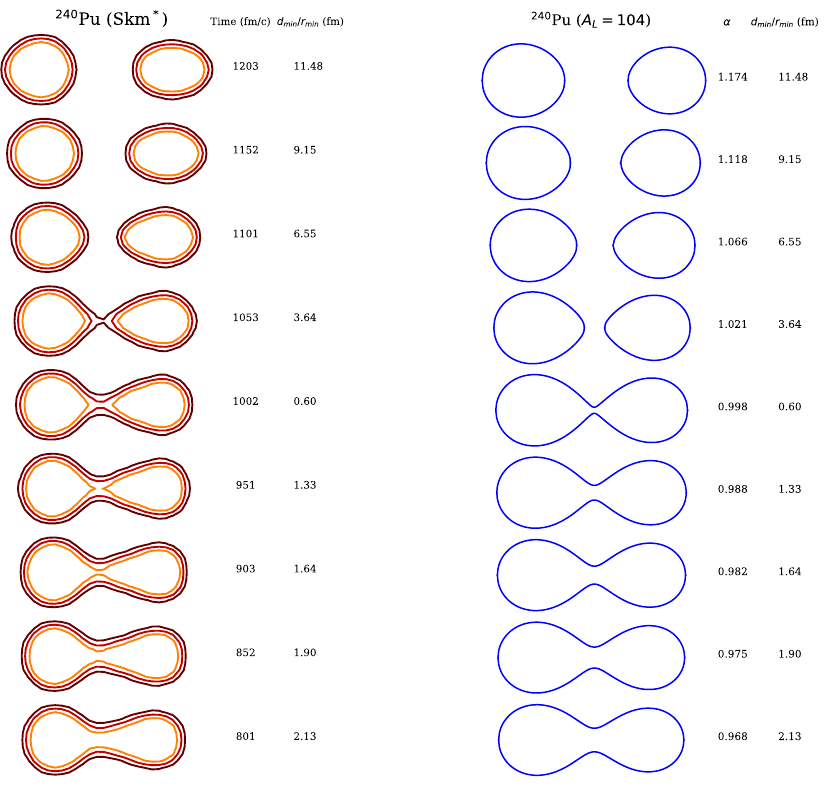
Figure 1. Time evolution of the density (left column) and of the potential (right column).